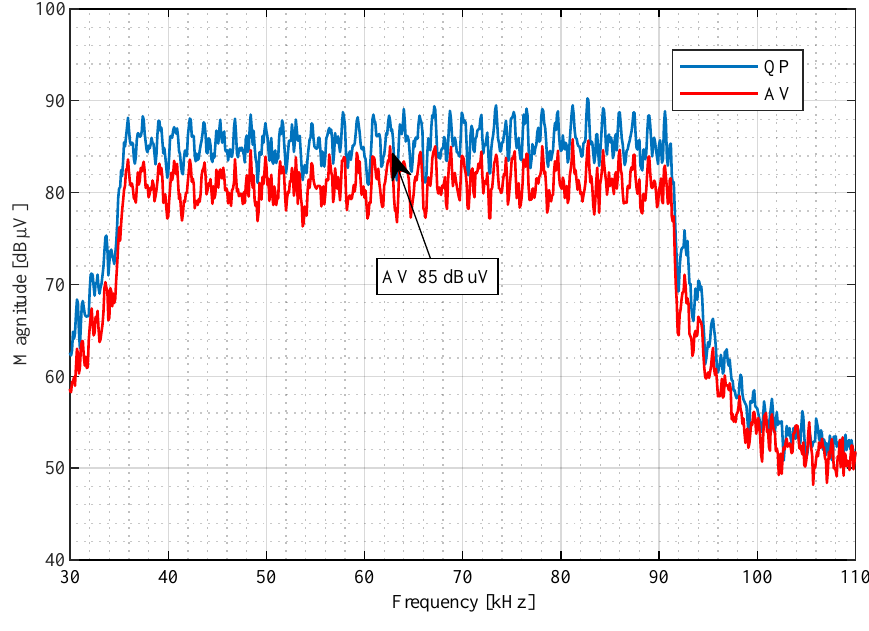
Figure 5. The spectrum of G3-PLC signal.